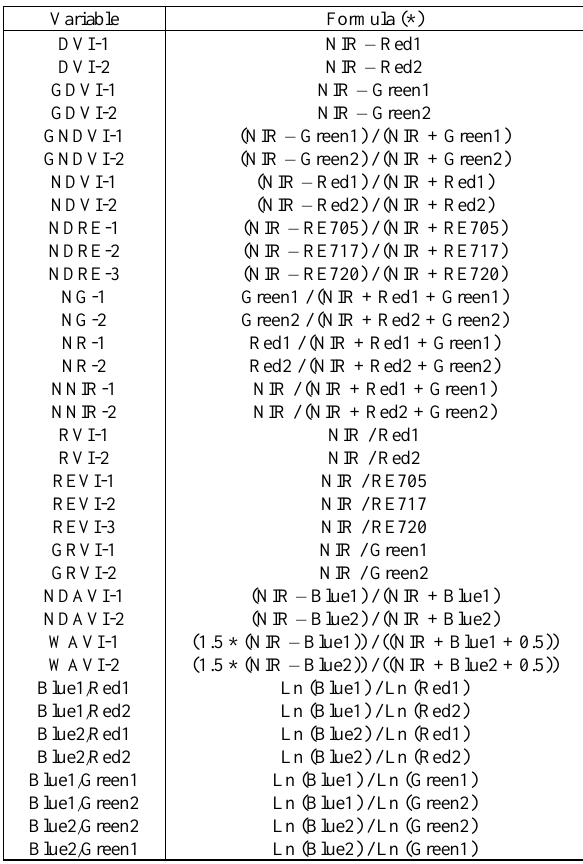
Vegetation indices and bathymetric ratios computed for the UAV images of Richibucto (adapted from the formula of Table 4).